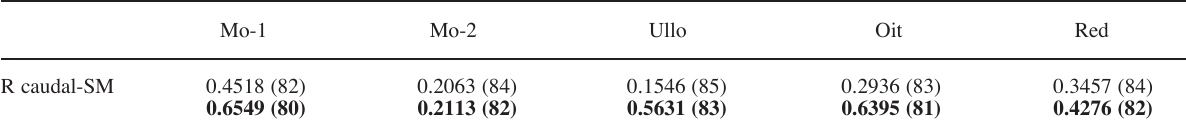
T ABLE 3. – Correlation coefficient values between SM and caudal for each river. The values were calculated for the period 1995-1997 with and without the samples of the 24/10/95 and the 14/10/95. Note that R values greatly improve for the Mo-1, Oit and Ull rivers indicating that those days contain a large percentage of the total